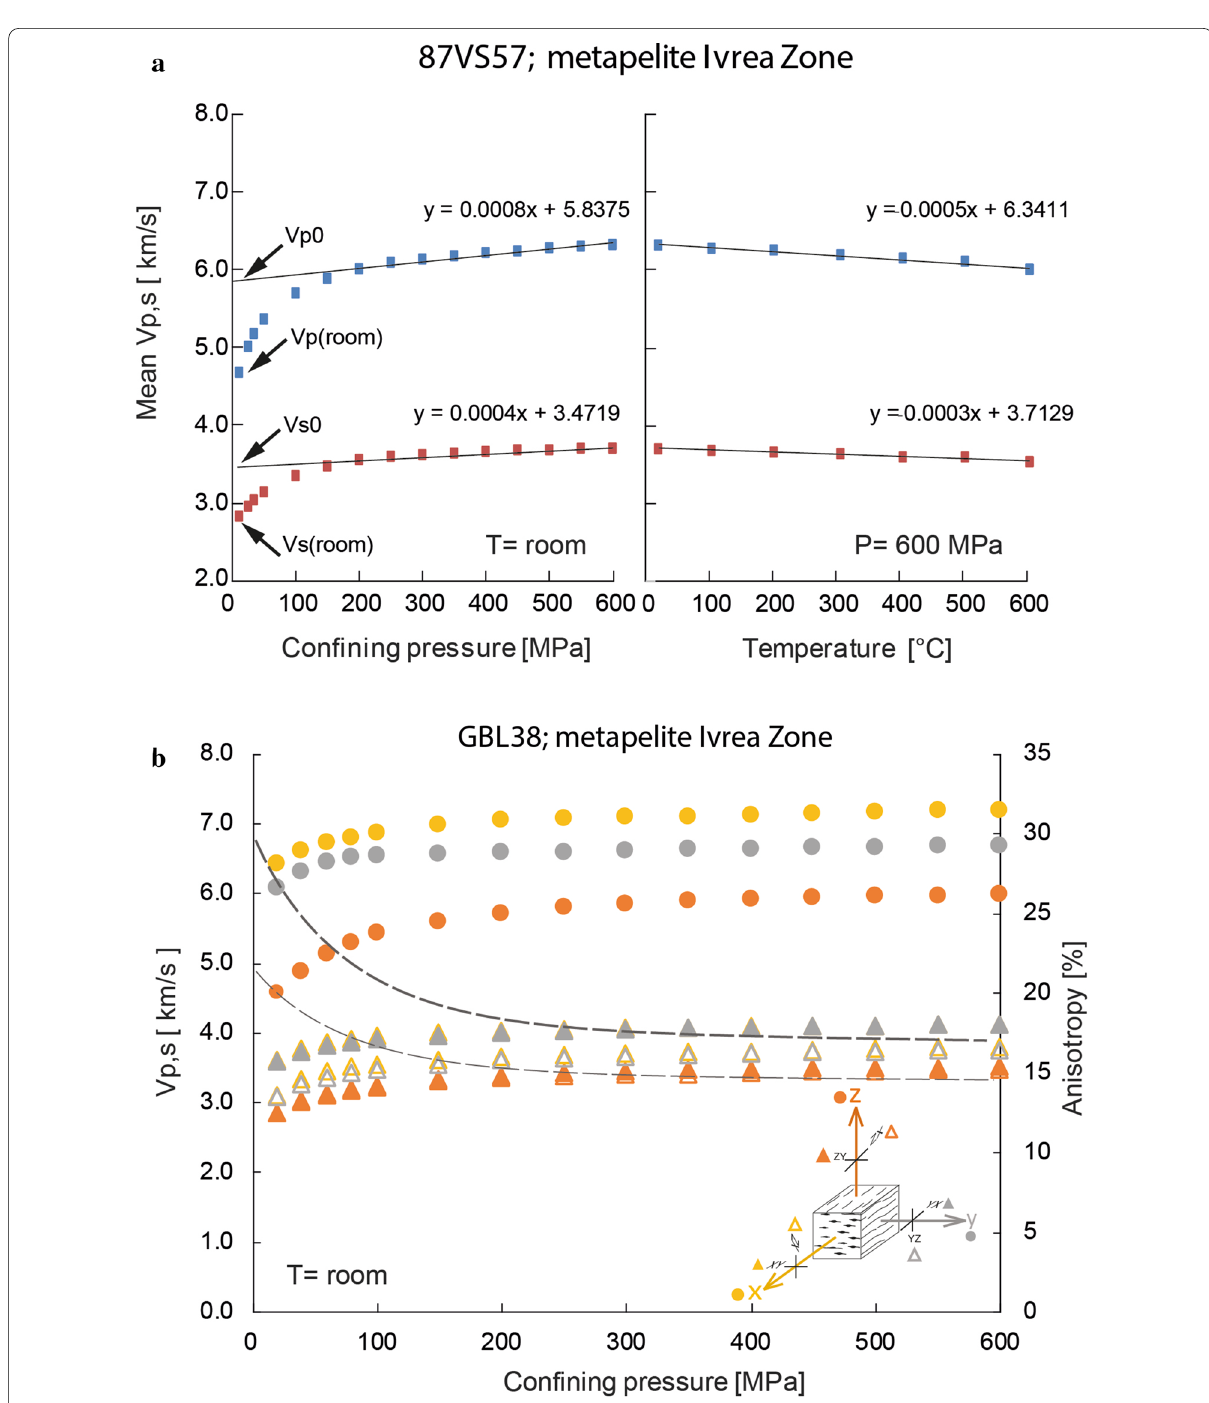
Fig. 5 Example of velocity curves from laboratory experiments (error bars within the symbols). a , b Effect of increasing pressure and temperature respectively on P and S waves; In a it is shown how intrinsic Vp0 and Vs0 are calculated from the intercept of the linear regression of the high pressure part of the curve (here above 150 MPa), and how they differ from room pressure. While for some application a “bulk” velocity might be sufficient, for many other applications the dependency of velocity over the direction of measurement and the anisotropy are important. c Shows a complete dataset of velocities measured along the main structural direction X parallel to lineation, Y perpendicular to lineation in the = = foliation or bedding plane, and Z perpendicular to foliation or bedding, as shown in the inset. Vs measured along the three structural direction are distinguished on the basis of the polarization plane, as shown in the inset. As Example Vszy is the S waves propagating perpendicular to foliation and with polarization in the zy plane, i.e. the plane normal to lineation. In this example, the velocities measured along the structural directions are quite different. The anisotropy calculated as (Vmax Vmin)/V average is also show in think dash line for Vp, and in grey dash line for −